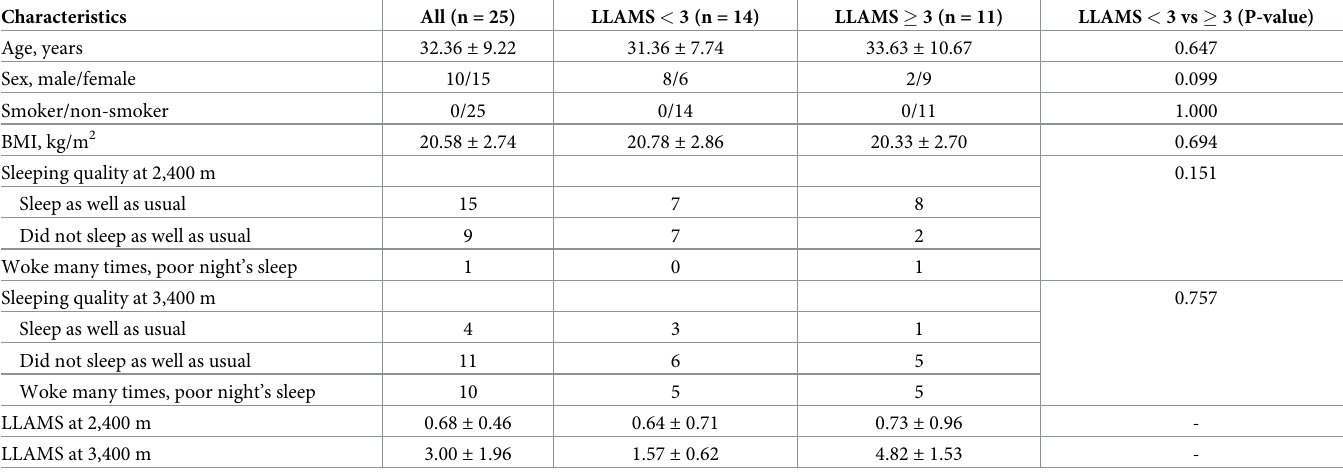
Table 1. Basic characteristics and LLAMS score among all participants, without (LLAMS < 3) and with AMS (LLAMS � 3) groups. Characteristics